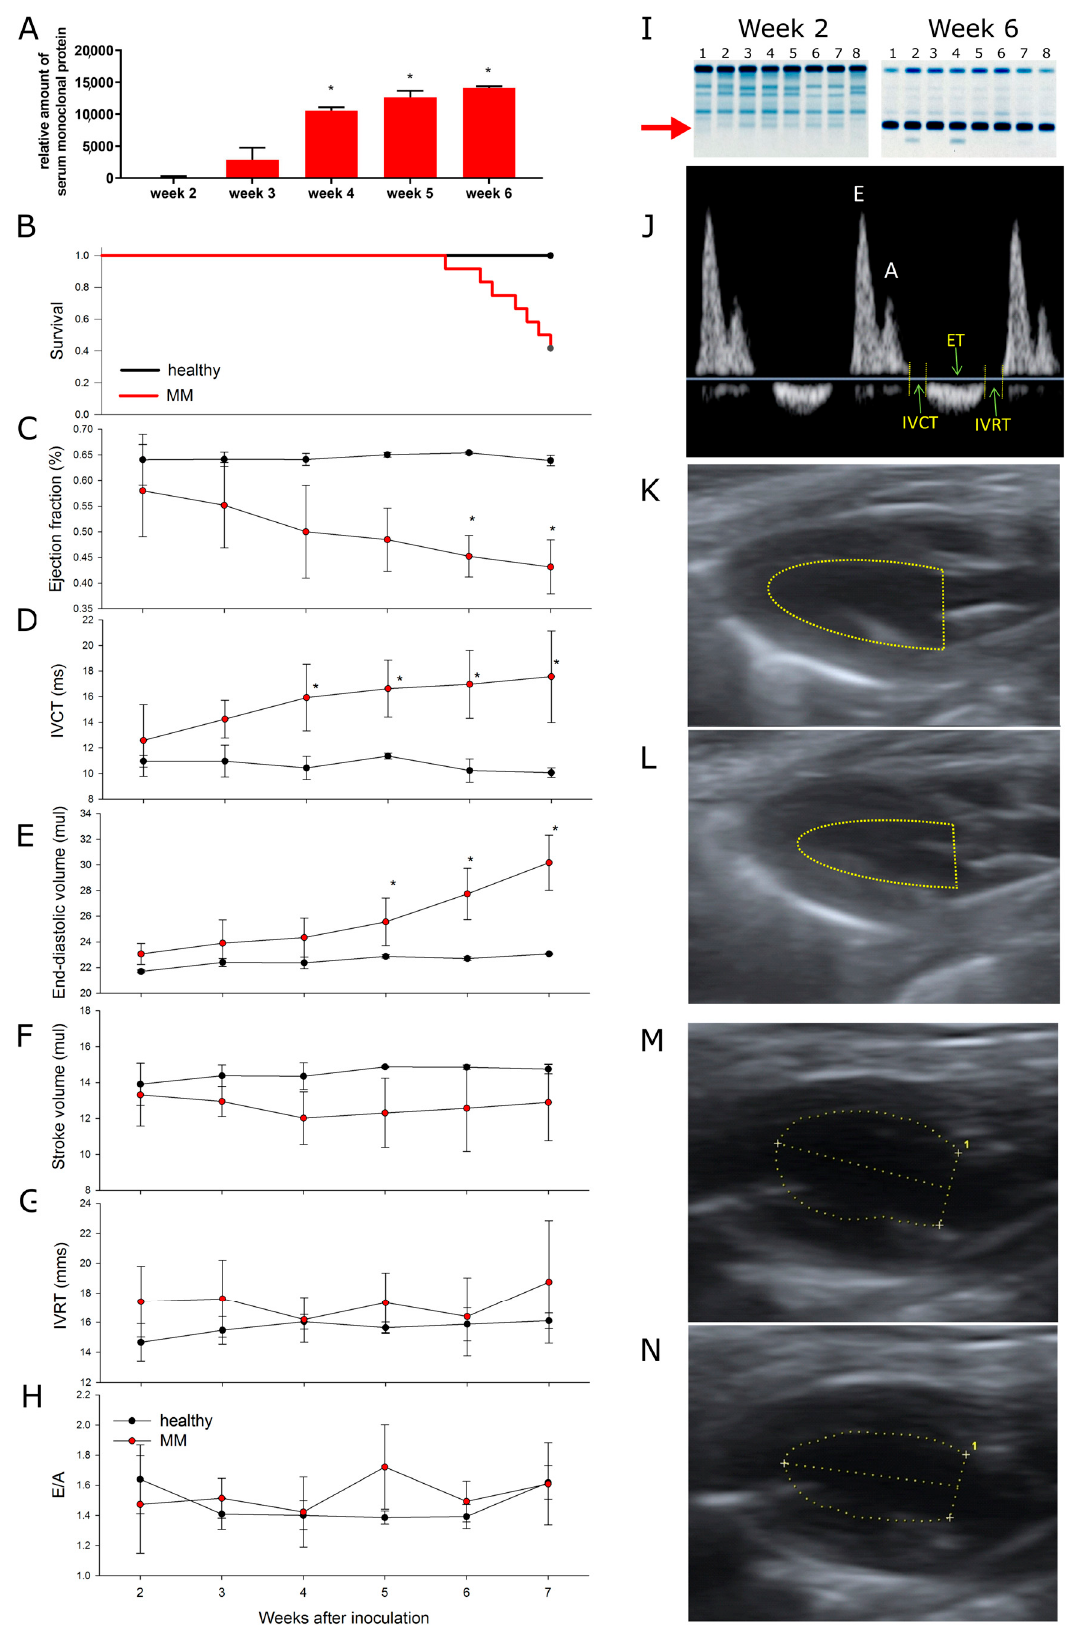
Figure 2. Progression over time of multiple myeloma and cardiotoxicity in a murine model of inoculation with V ĸ *MYC cells. ( A ) Relative amount of serum monoclonal protein, ( B ) Survival of multiple myeloma [MM] and healthy mice after inoculation of MM cells, ( C ) Left ventricular [LV]